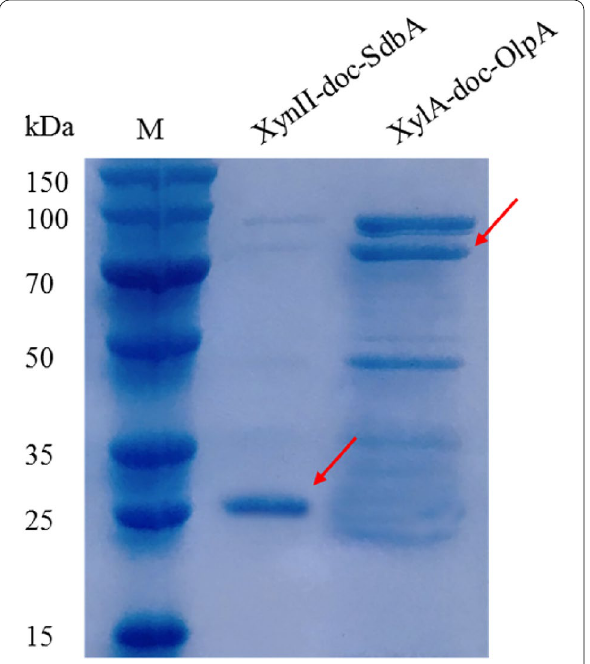
Fig. 3 Analysis protein secreted expression by SDS–PAGE gel staining with Coomassie bright